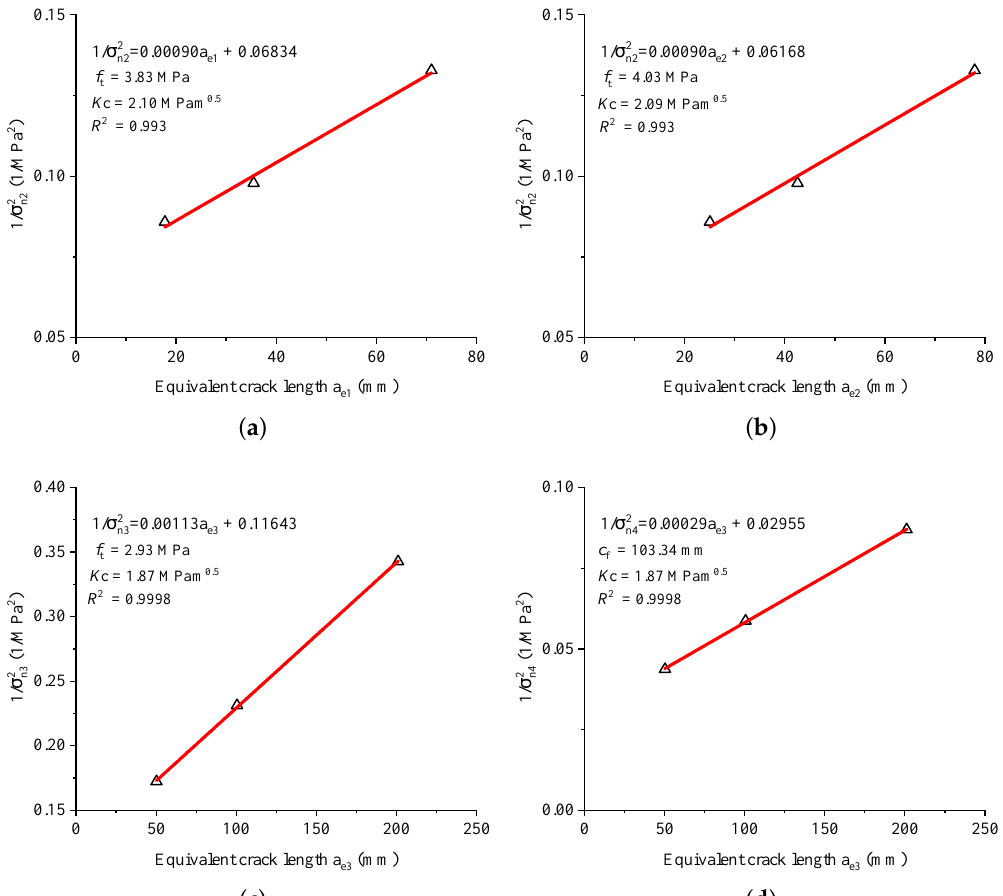
Figure 6. Test results in [30] and the corresponding fitted curves of ( a ) Hu-Guan’s boundary effect model with β 1 = 1, ( b ) modified Hu-Guan’s boundary effect model with β 1 = 1, ( c ) Koval-Gao’s size and boundary effect model and ( d ) Bažant’s Type 2 size effect